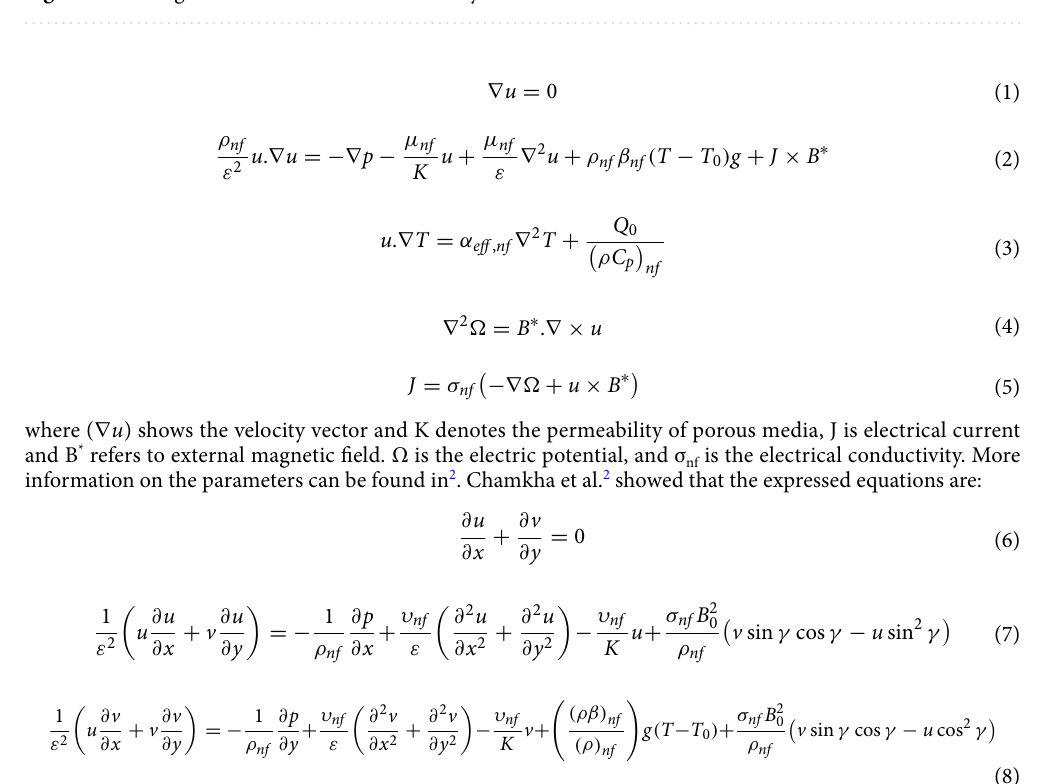
Figure 1. Mesh generation and different boundary conditions in two